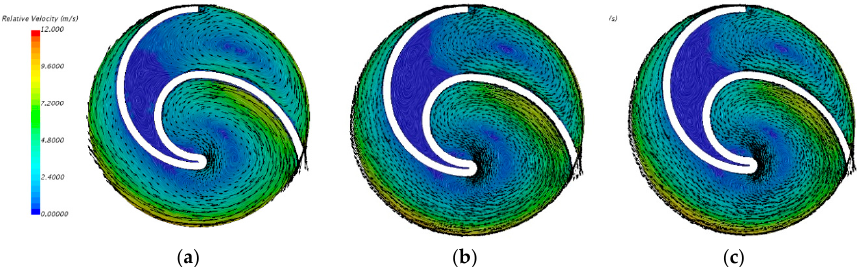
Figure 11. Relative velocity field of the liquid phase at the mid-span of the impeller for the three shape cases: ( a ) cylinder particle, ( b ) pie-shaped particle, ( c ) spherical particle.